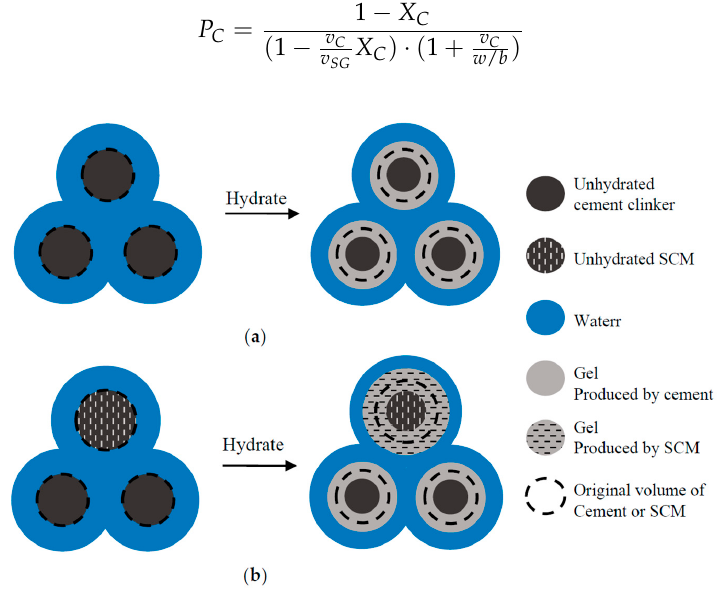
Figure 13. Hydration process of cement paste within the framework of gel/space ratio: ( a ) Cement unary system; and ( b ) C-SF-FA system